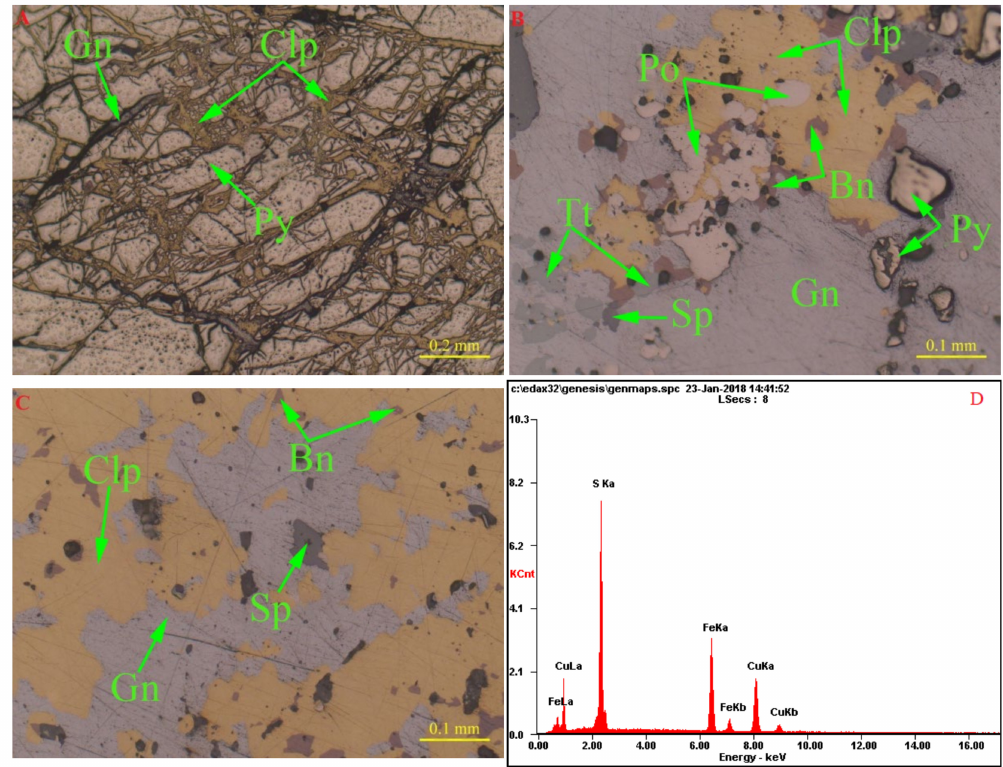
Figure 2. Images and EDS analysis of chalcopyrite (Abbreviations used: Gn = galena, Clp = chalcopy- rite, Py = pyrite, Bn = bornite, Po = pyrrhotite, Tt = Tetrahedrite, Sp = sphalerite, Cc = Chalcocite, Bet = Betekhtinite and Str = Stromeyerite. Green arrows indicate minerals); ( A – C ) represents the symbiotic relationship between chalcopyrite and other minerals); ( D ) represents the EDS analysis of